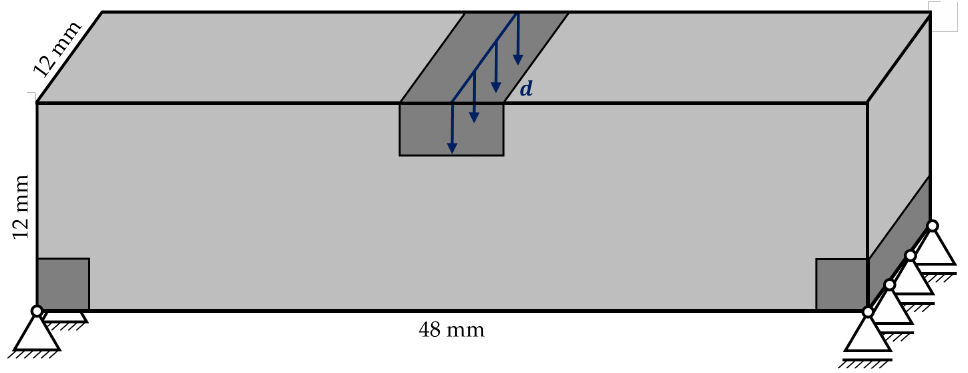
Figure 15. Three-point bending beam with dimensions, clamping, load and restricted